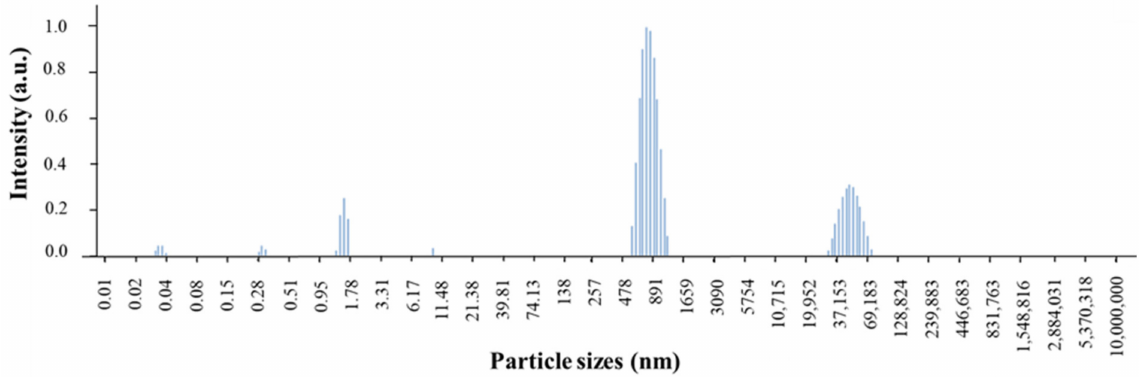
Figure 8. Particle size distribution of Ni/ γ -Al 2 O 3 slurry sol (sample